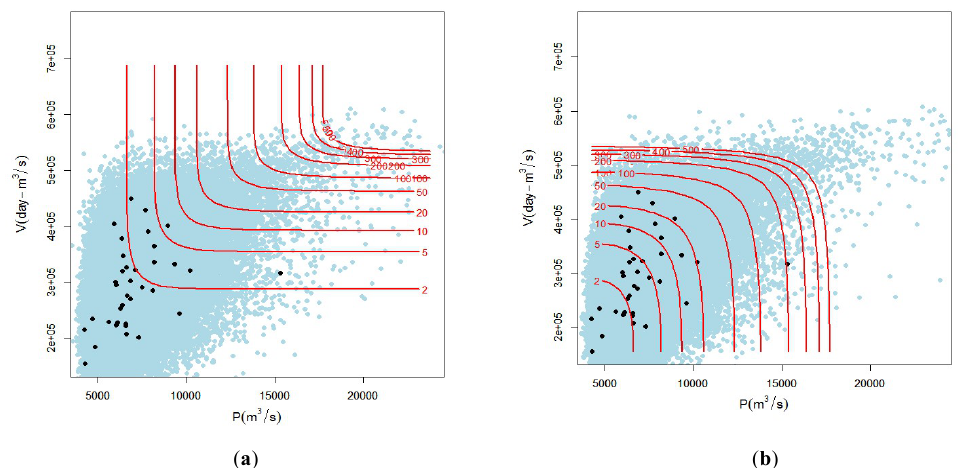
Figure 6. Primary return periods T OR . Primary return periods T AND.